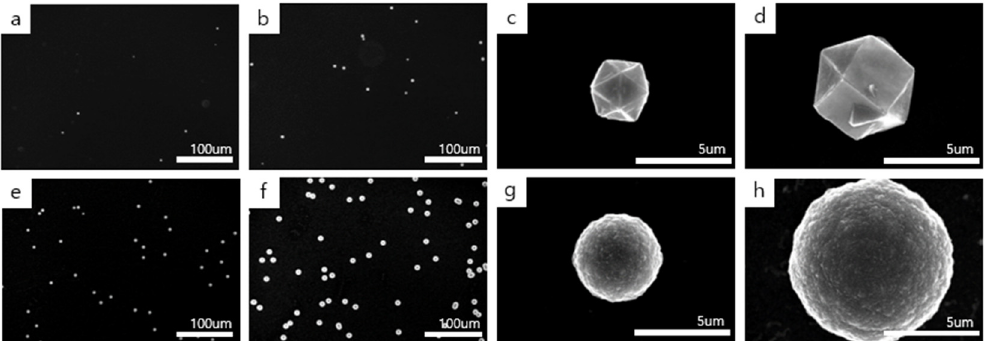
Figure 2. FE-SEM images of diamond particles deposited on the Si substrate at a filament tempera- ture of 2100 °C . ( a,b ) show the low magnification image of diamond particles deposited for 4 h and 8 h, respectively, at 1% CH 4 –99% H 2 , with ( c,d ) being the high magnification images, respectively, of ( a,b ). ( e,f ) show the low magnification image of diamond particles deposited for 4 h and 8 h, respectively, at 3% CH 4 –97% H 2 , with ( g,h ) being the high magnification image, respectively, of ( e,f ).